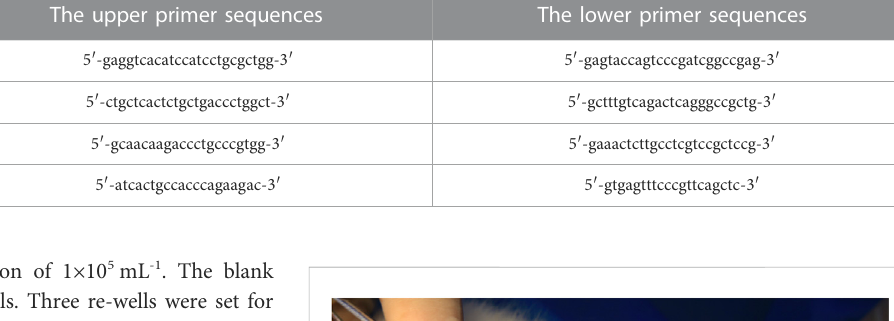
TABLE 4 The upper and lower primer sequences. Gene The upper primer sequences The lower primer sequences